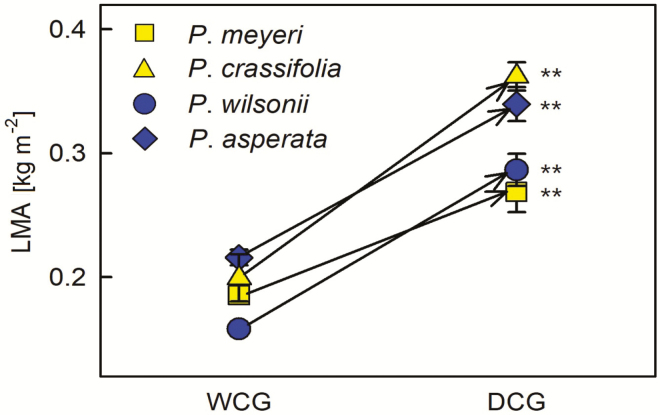
Differences in leaf mass per area (LMA) between WCG and DCG for each species. Yellow symbols indicate the species from the dry habitat and blue symbols indicate the species from the wet habitat. The lines show mean values and standard error of means across three replicates for each measurement, plotted against drought treatments. **P < 0.01.